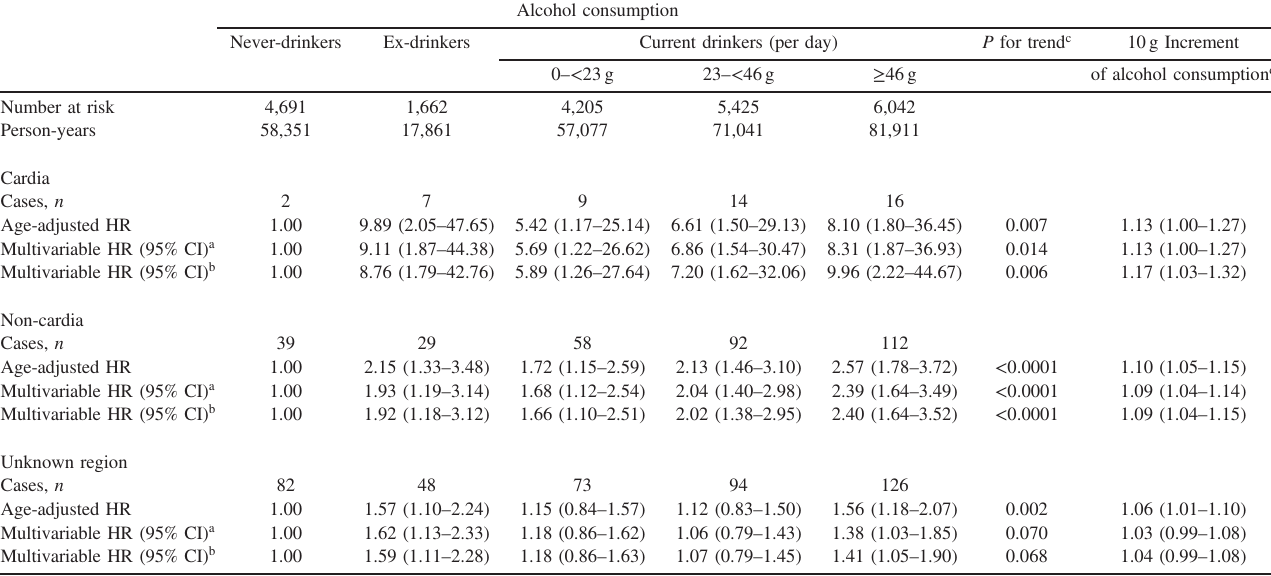
Table 3. Hazard ratios of cardia, non-cardia and unknown regions of gastric cancer according to alcohol consumption categories among